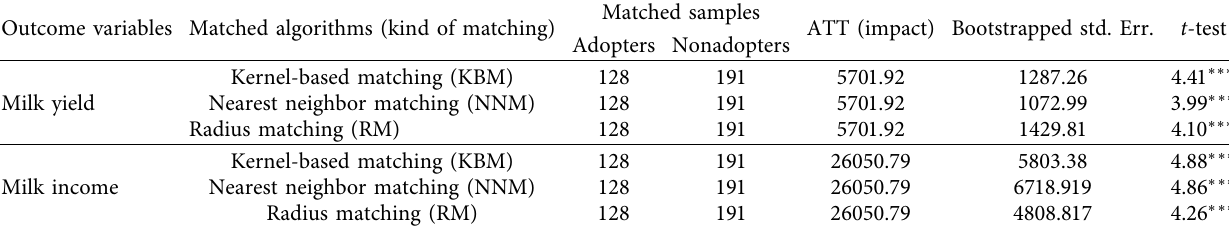
Table 8: Performance criteria of matching